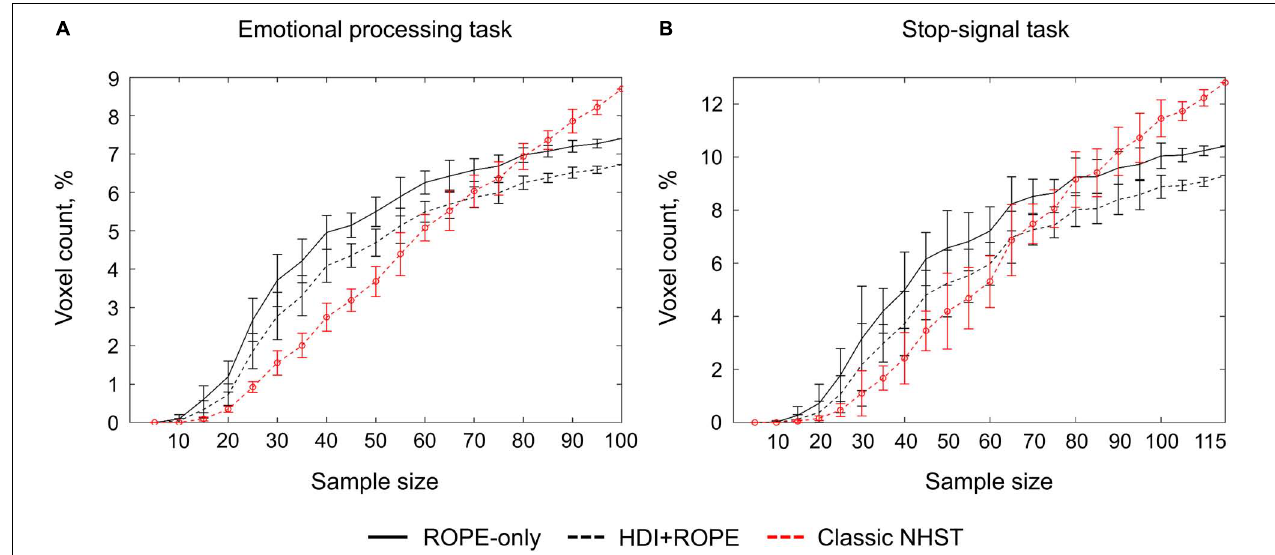
FIGURE 13 | Dependencies of the number of ‘activated’ voxels on the sample size. Classical NHST was implemented using FWE correction ( α = 0.05). BPI was implemented using γ = 1 prior SD θ . (A) The emotional processing task (block design, ‘Emotion > Shape’ contrast). (B) The stop-signal task (event-related design, ‘Correct Stop > Go’ contrast). The error bars represent the mean and standard deviation across ten random